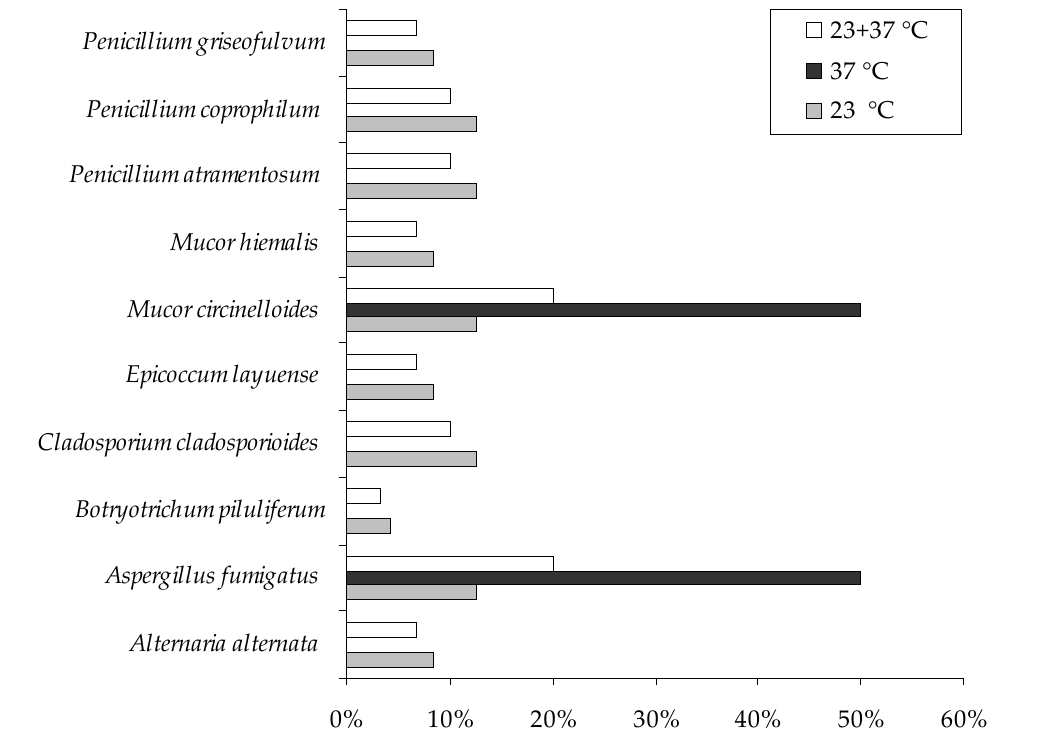
Figure 2. Percentage of each fungal species concerning the total isolated fungi from all studied biological materials of grey heron nests.